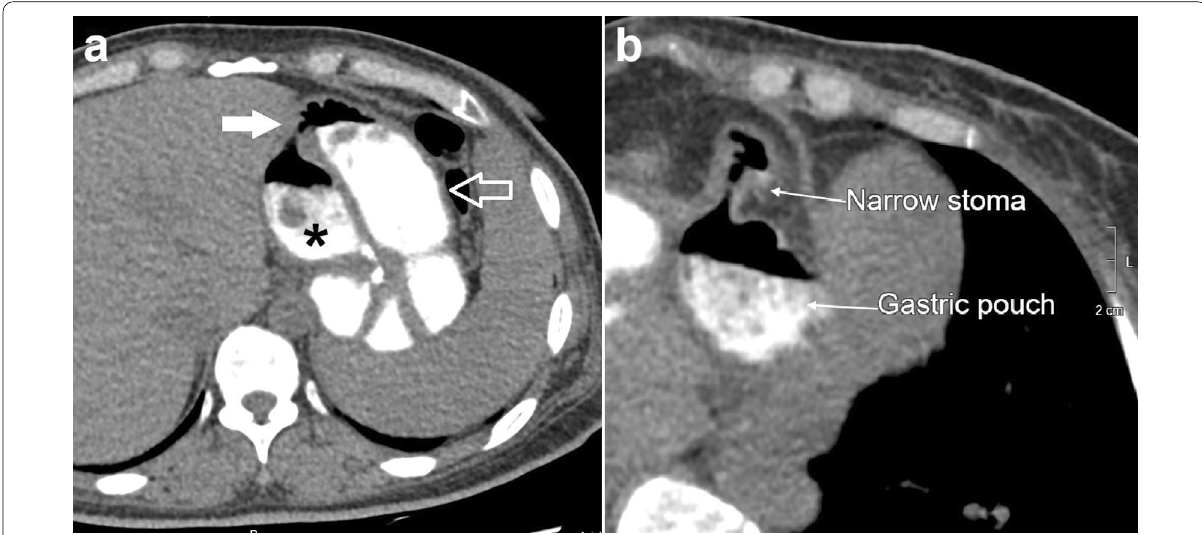
Fig. 5 Vertical banded gastroplasty complicated with narrowed stoma. Axial CT image reveals the significant narrowing of gastric stoma (solid arrow) connecting gastric pouch (*) with remaining stomach (open arrow). Food particles are retained within gastric pouch denoting significant stenosis of the stoma. Part of the radiodense stapling material is noted as well. Axial oblique reformatted image ( b ) through the anatomical plane of the stoma accurately demonstrates the significant